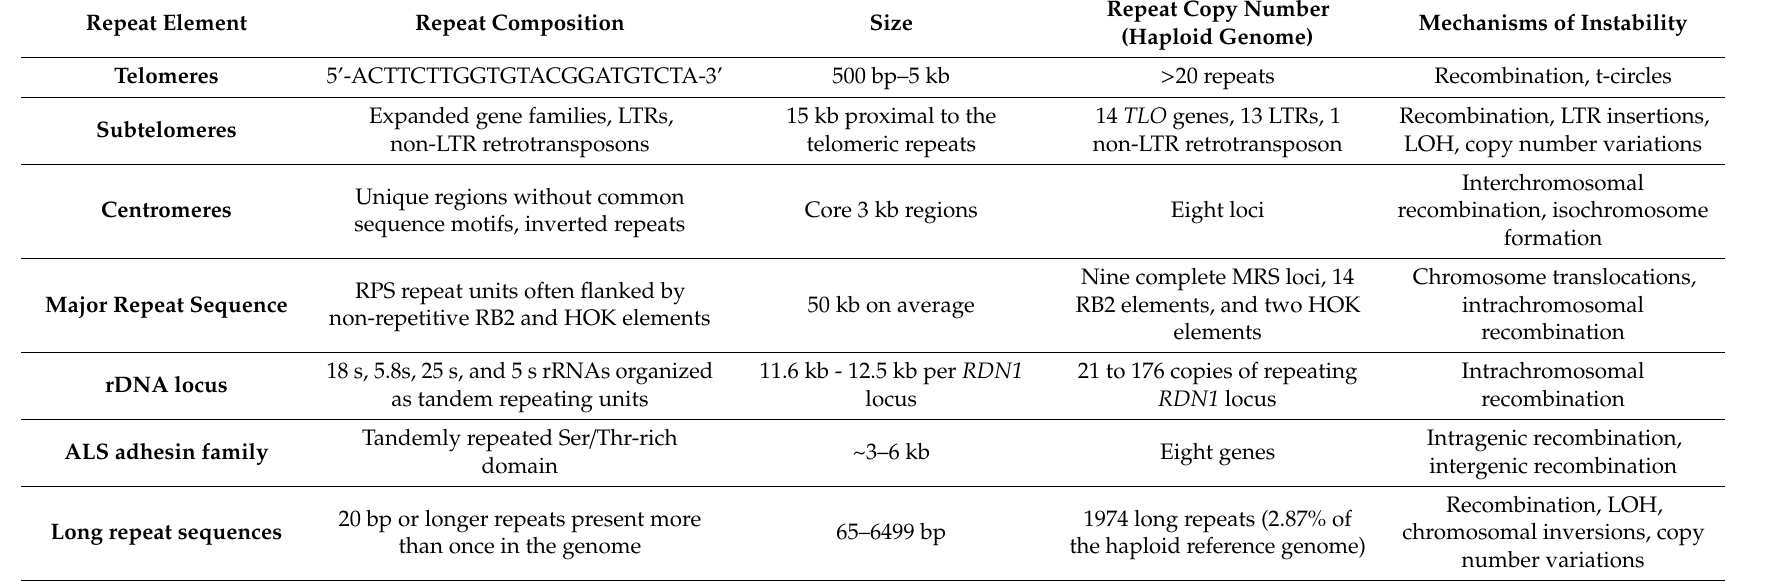
Table 1. Repeat composition summary in C. albicans